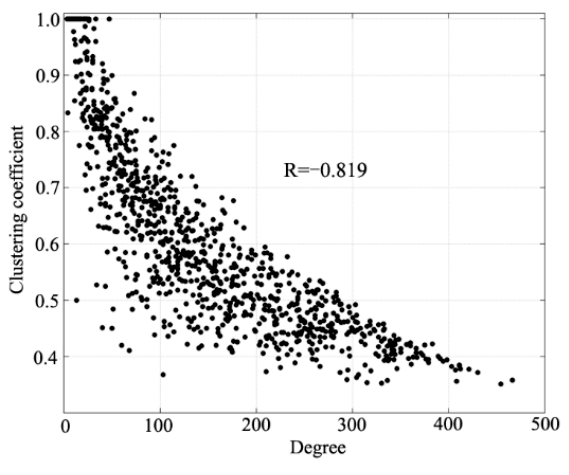
Figure 6. Correlation of degree and clustering coefficient.